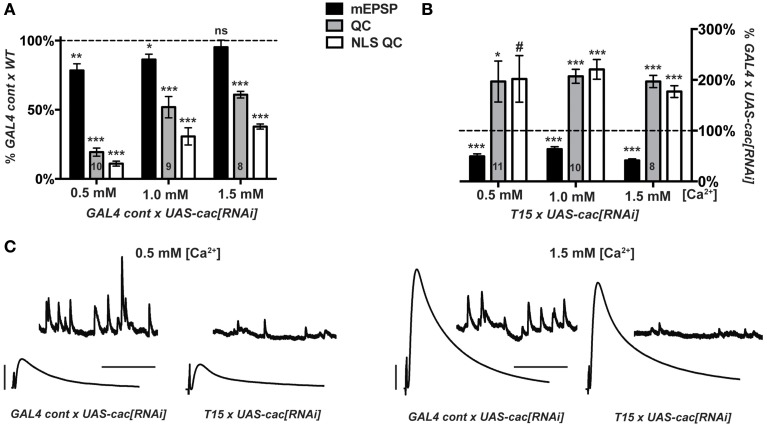
Knock down of cacophony gene function does not impair synaptic homeostasis. (A,B) mEPSP (black), QC (gray), NLS QC (white). (#p = 0.05; *p < 0.05; **p < 0.01; ***p < 0.001, T-test compared to control at 100% dotted line) (A) Diminished baseline neurotransmission for GAL4 control × UAS-cac[RNAi] larvae is consistent with cac gene knock down. Diminished release occurs across a range of extracellular [Ca2+]. (B)
T15 × UAS-cac[RNAi] larvae show robust homeostatic compensation compared to GAL4 control × UAS-cac[RNAi] larvae. As expected, the T15 line induces a marked diminishment of quantal size (mEPSP). The NMJ responds with a robust increase in release. This response is observed across a range of extracellular calcium concentrations, and the same result holds whether or not QC is corrected for non-linear summation. (C) Representative electrophysiological traces. Scale bars for EPSPs (mEPSPs): 5 mV (1 mV); 50 ms (1000 ms).